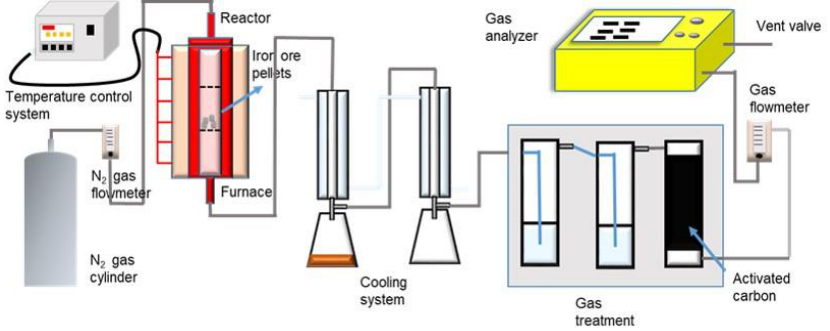
Figure 1. Scheme of apparatus for reduction experiments .